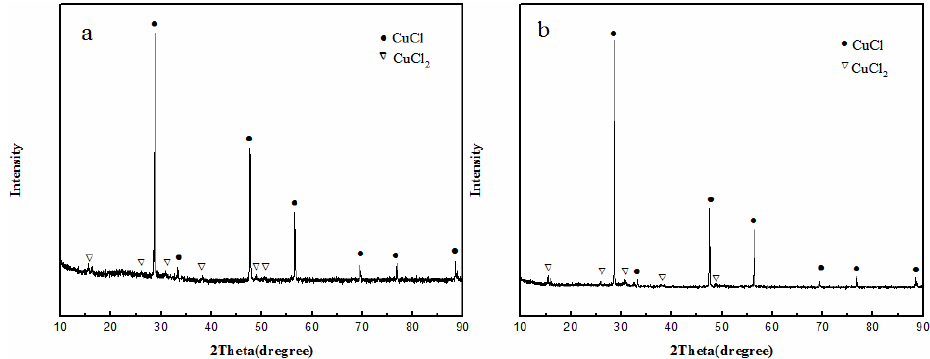
Figure 7. XRD pattern of heating product of the crystals A ( a ), B ( b ).